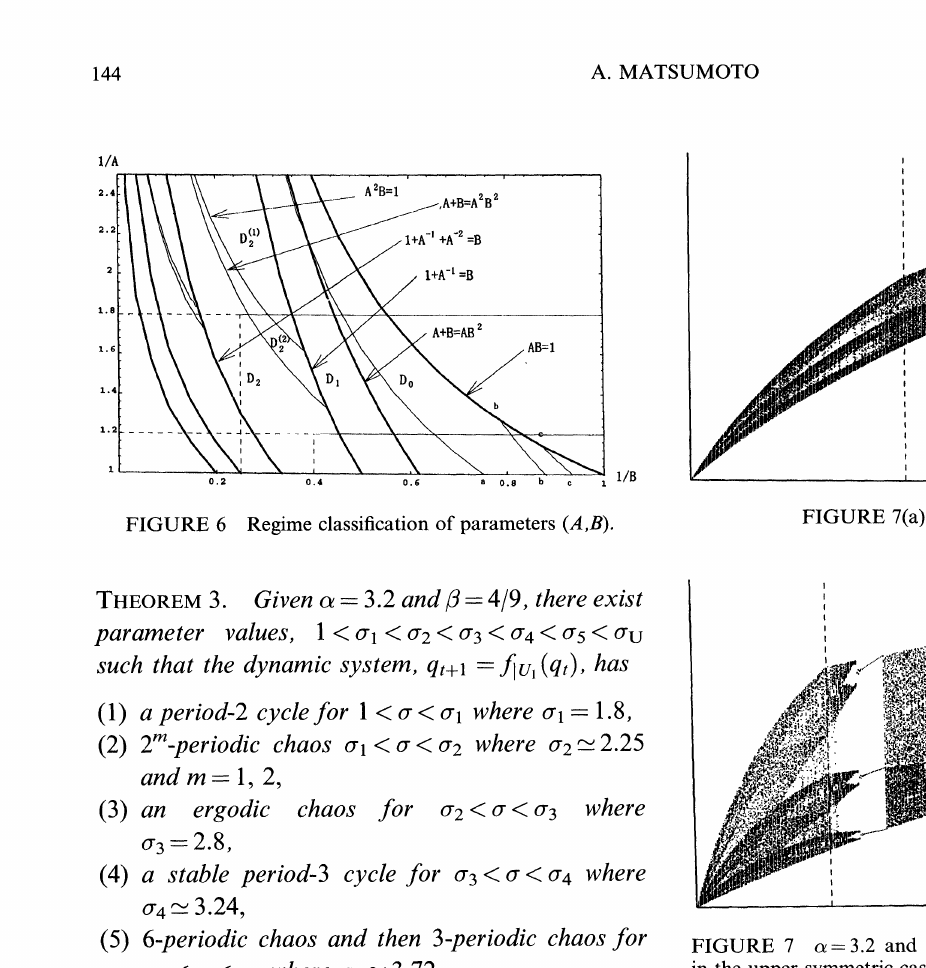
FIGURE 7 a= 3.2 and 3=8/9. Two bifurcation diagrams in the upper-symmetric case.